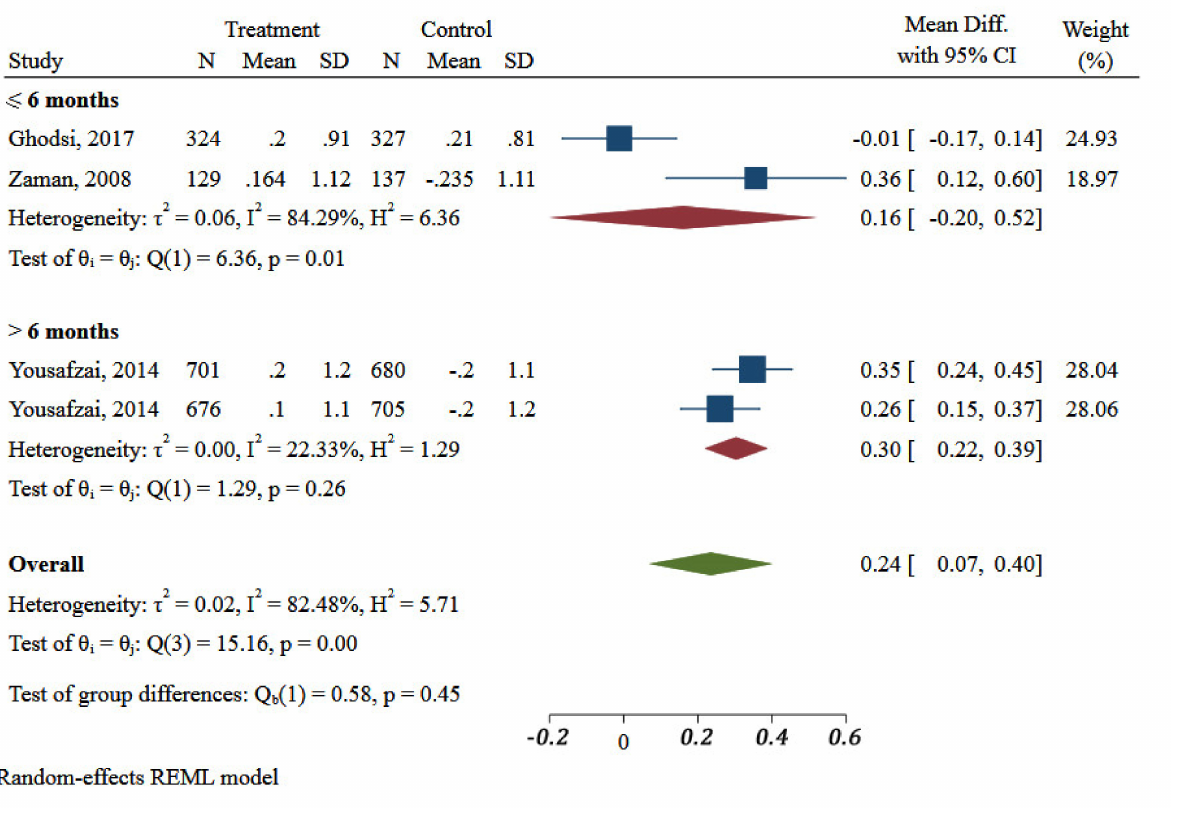
Figure 7. Impact of different community-based nutrition intervention duration on Weight-for-Height Z-score of children under 5 in Eastern Mediterranean